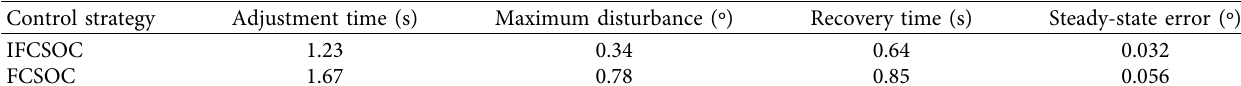
Table 2: Step simulation data.